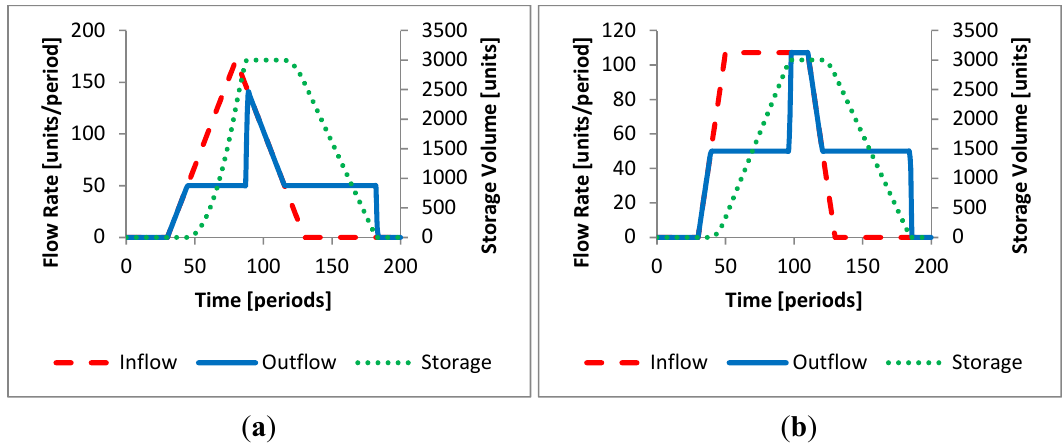
Figure 6. Minimize flood frequency rule (flooding occurs) for ( a ) Triangular hydrograph and ( b ) Broad peak hydrograph.